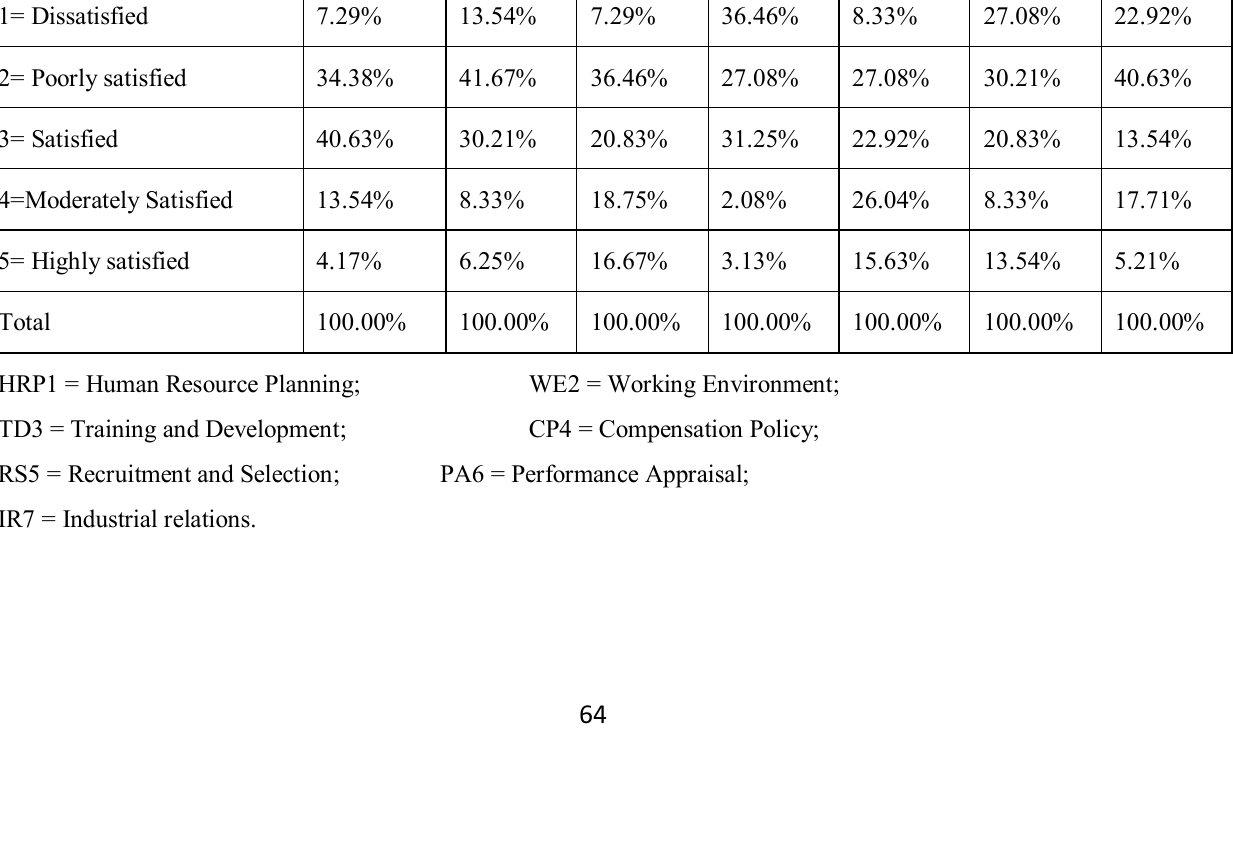
Table1: Percentage of employees in different level of satisfaction under HRM Factors: HRP1 WE2 TD3 CP4 RS5 PA6 IR7 1= Dissatisfied 7.29% 13.54% 7.29% 2= Poorly satisfied 34.38%